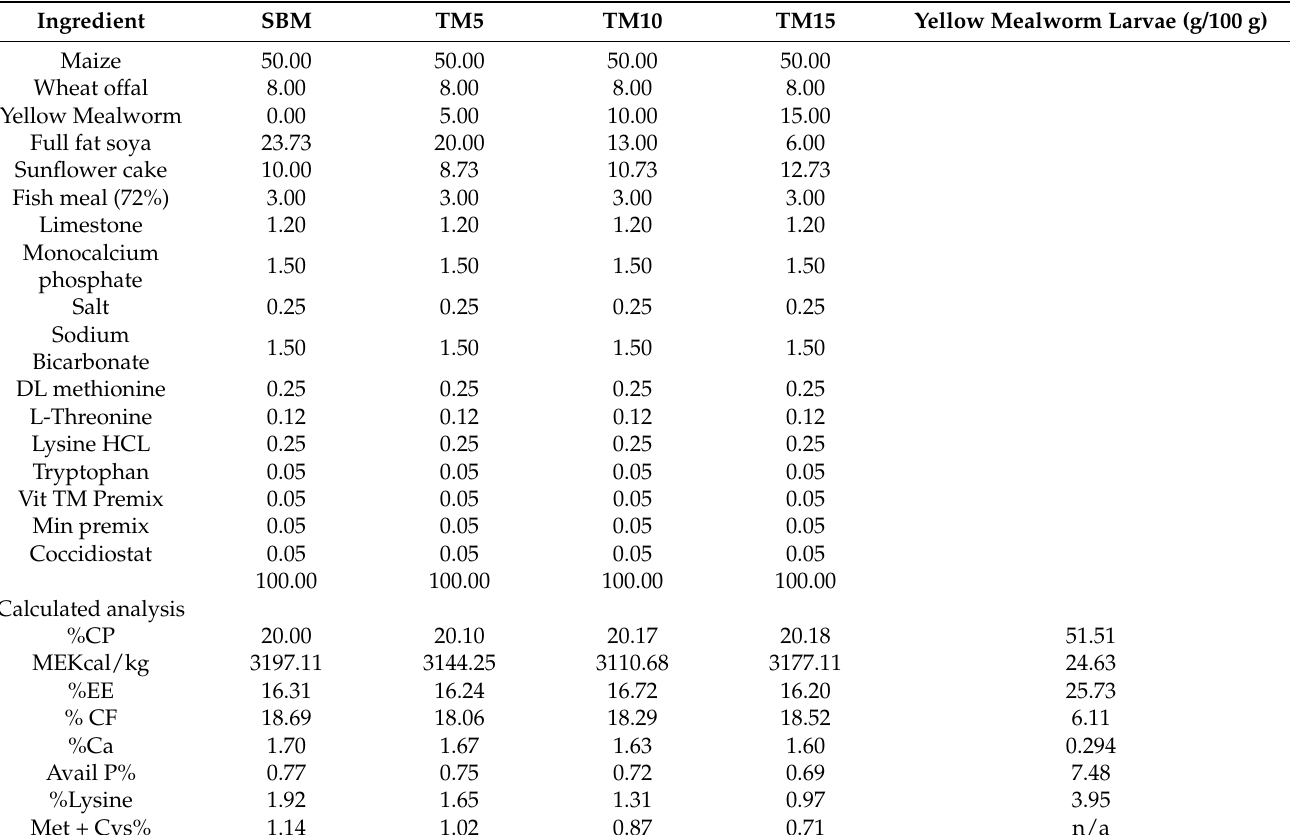
Table 1. Ingredients and the calculated analysis of yellow mealworm larvae meal and experimental diets